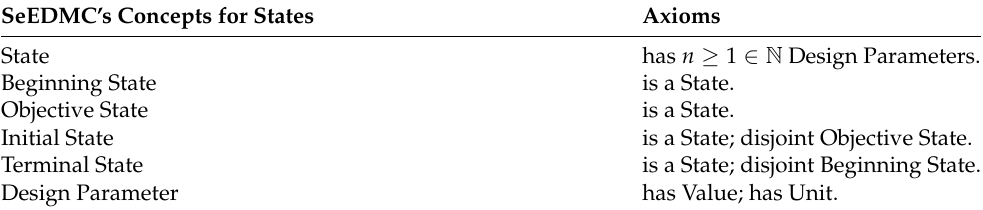
Table 1. Axioms for States.